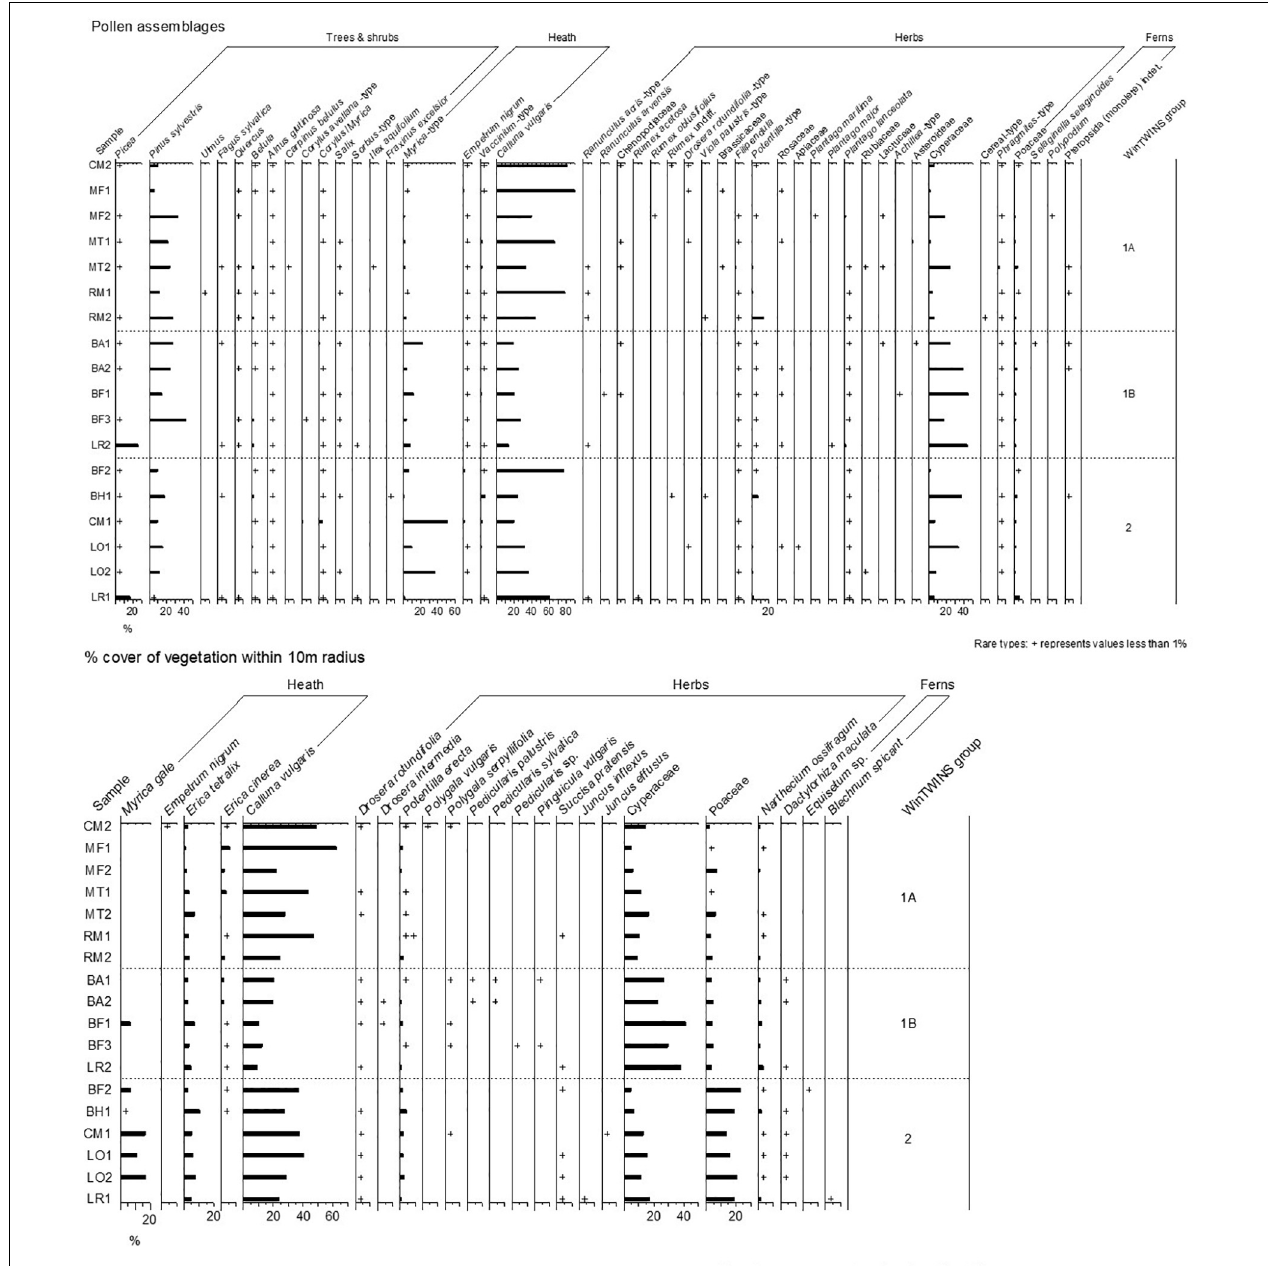
FIGURE 2 | Pollen percentages and % vegetation cover within 10 m of the sample point for samples collected in this study. Vegetation cover is grouped into palynological equivalents. Sample locations and codes are shown in Figure 1 .